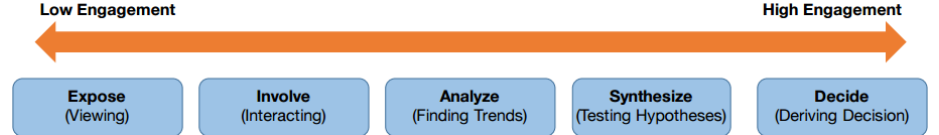
Figure 12. Mahyar et al. present five levels of user engagement in information visualization [31]. Image courtesy of Mahyar et al.